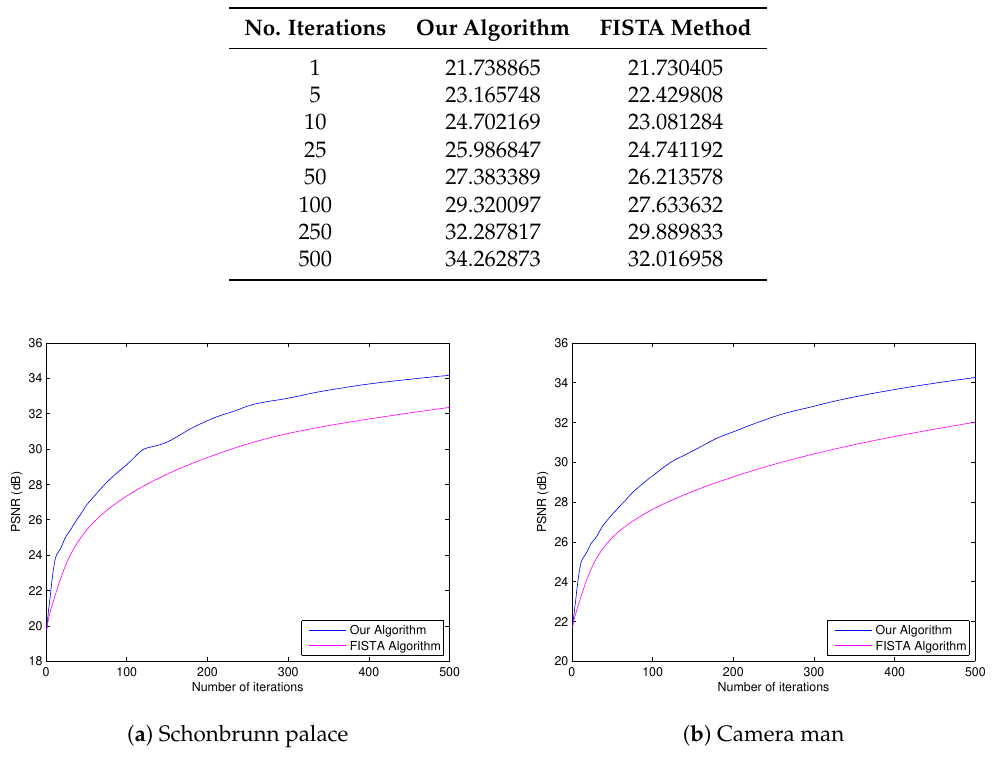
Table 4. The values of PSNR at x 1 , x 5 , x 10 , x 25 , x 50 , x 100 , x 250 , x 500 (Camera man).